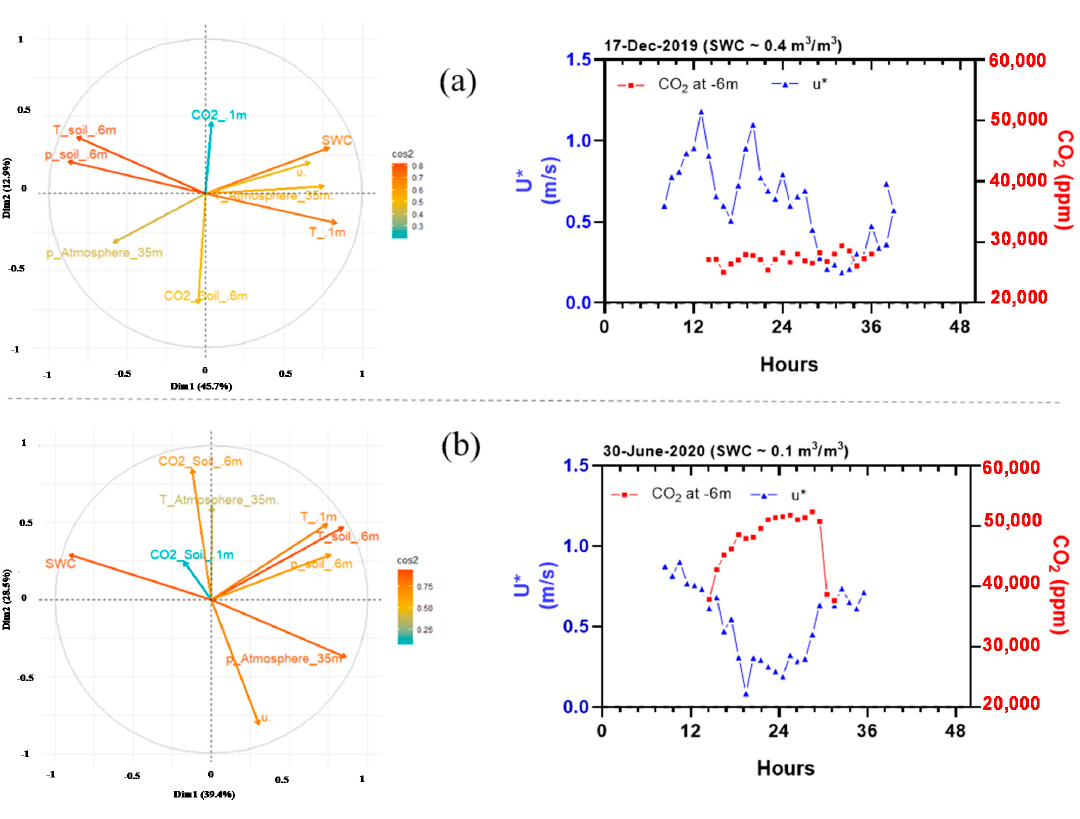
Figure 7. The left side of the figure indicates the principal component analysis (PCA) of hourly data spanning from 19 September 2019 to 23 July 2020, and the right side shows an intraday variation of hourly u* and CO 2 during 48 h. Part a corresponds to wet periods (SWC > 0.2 m 3 /m 3 ), and Part b represents dry periods (SWC ≤ 0.2 m 3 /m 3 ).